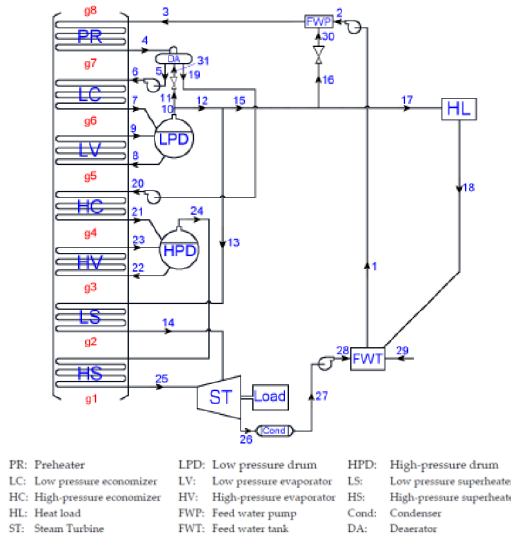
Figure 4. Bottoming cycle and internal structure of the HRSG.